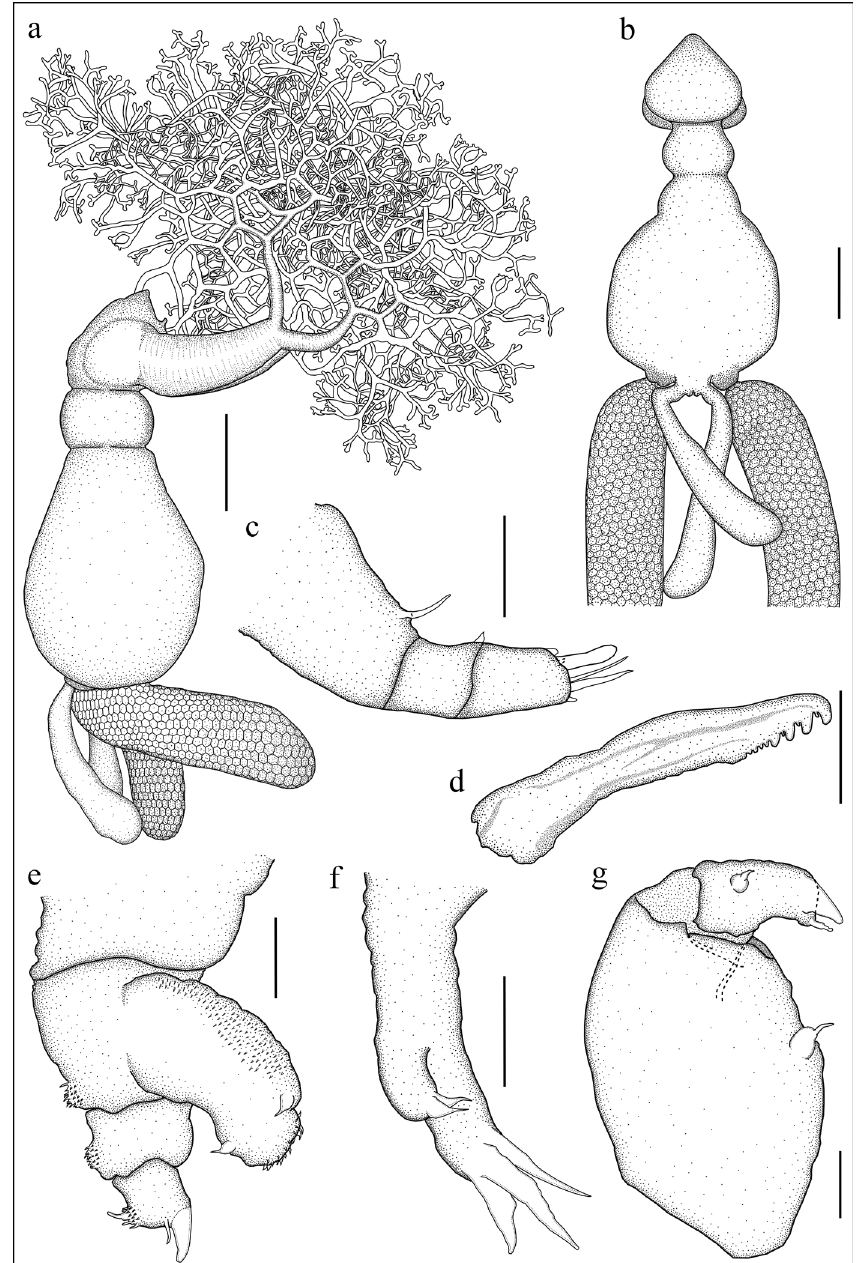
Figure. 1 Dendrapta nasicola n. sp. (adult female) from Bathyraja scaphiops (Arhynchobatidae). a general habitus (lateral view), composite drawing. b general habitus (ventral view) c antennule. d mandible. e antenna. f maxillule. g maxilliped. Scale bars: a, b = 2.5 mm; c – g = 50